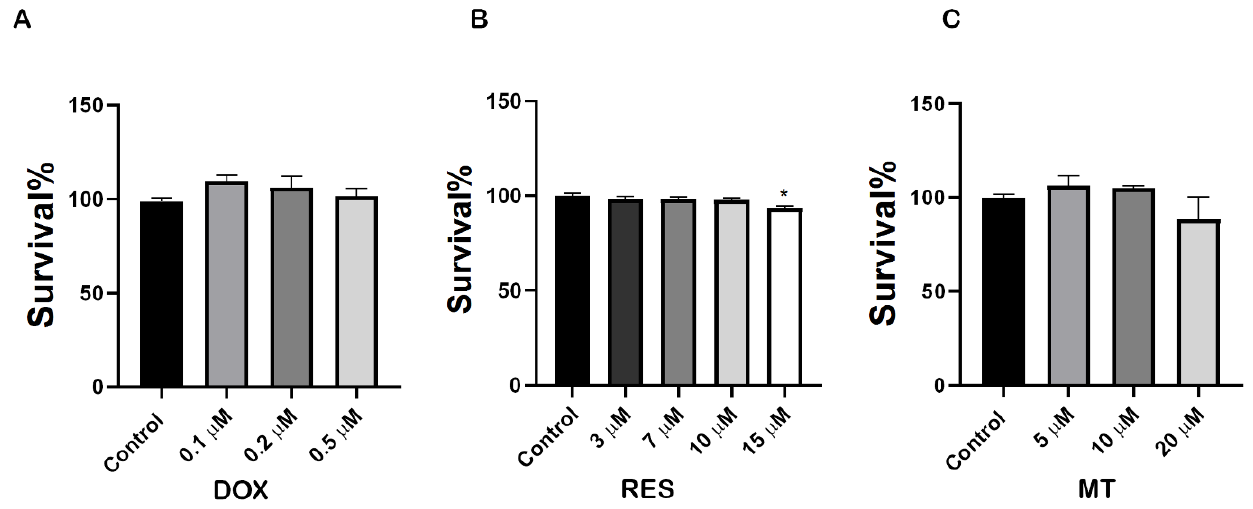
Figure 1. Cytotoxicity of doxorubicin and antioxidants on RAW 264.7 cells. RAW 264.7 cells were exposed to different concentrations of Doxorubicin (DOX) ( A ), Resveratrol (RES) ( B ) and MitoTEMPO (MT) ( C ) and an XTT assay was performed. Cells were treated for 3 days with RES and MT, and for 3 h with DOX. One-way ANOVA, Tukey’s multiple comparisons test, *— p ≤ 0.05.